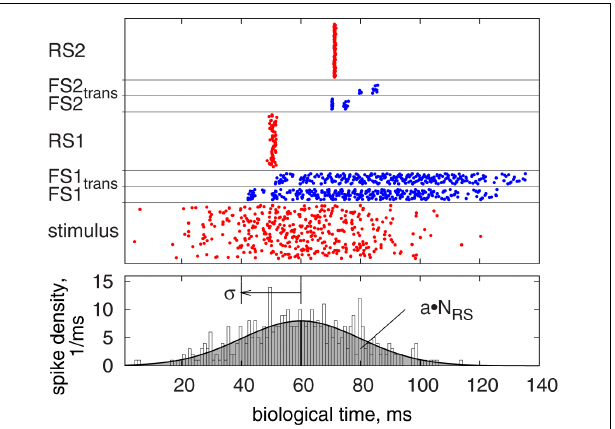
FIGURE 11 |A sample pulse pattern of the synfire chain, with pulses of the inhibitory FS populations transmitted via the PCS. Upper plot: pulses sorted by population, from the bottom: initial stimulus, resultant activity of the first inhibitory FS population before (FS1) and after (FS1 trans ) transmission, activity of the first excitatory RS population (RS1), and the corresponding patterns for the second group of populations (compare Figure 8 ). Lower plot: given spike density and resulting histogram of the stimulus in the upper plot. Parameters are a = 4, σ = 20ms, FS-to-RS (hardware) delay